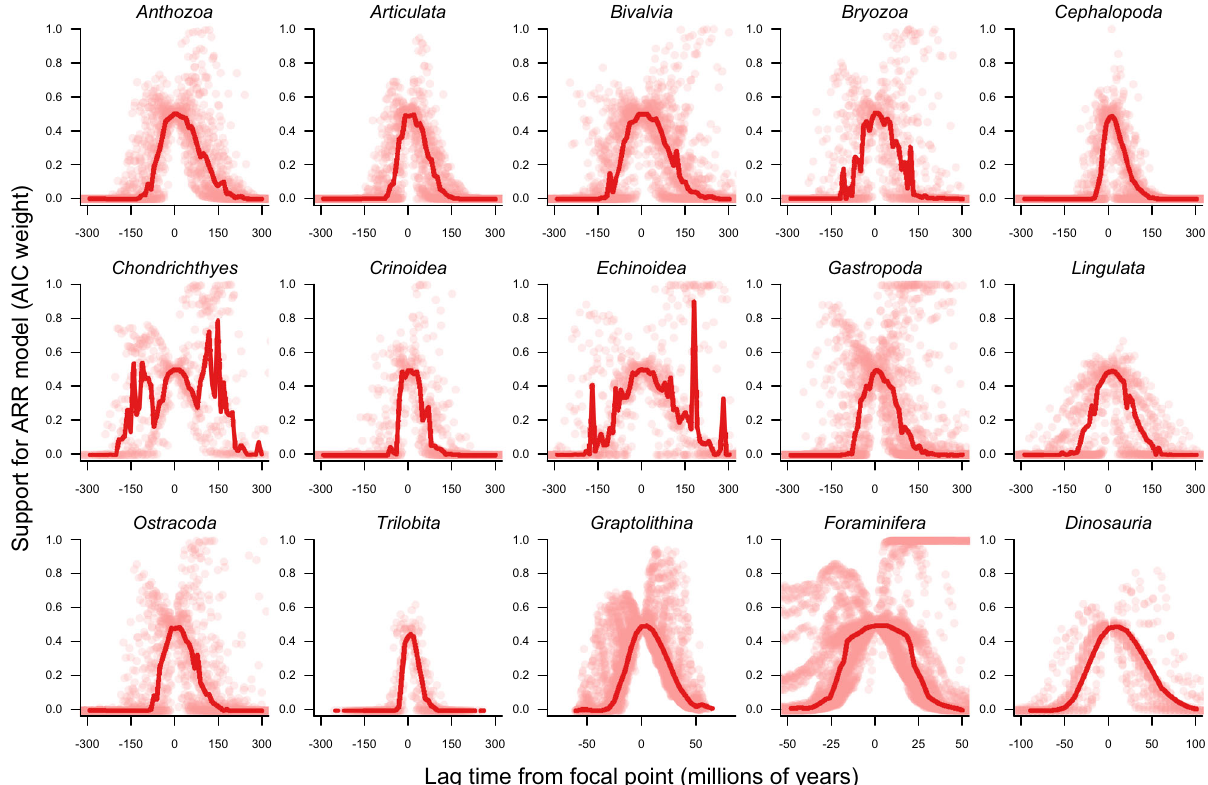
Fig. 4 Probability (AIC weight) of ARR model relative to a nonbiological “ constant ” model as a function of temporal lag. Weights are shown for all pairwise combinations of timepoints for each dataset; red line denotes median weight of ARR model for binned lag times. A value of 0.5 indicates that ARR and constant models have equivalent probability; values approaching 1 imply superior performance of the ARR model. For both positive lags (forwards-in- time) and negative lags (backwards-in-time), the ARR model is outperformed by the constant model. Across all pairs of timepoints ( n = 25740), the ARR model was strongly favored (weight > 0.95) for only 1.8% of comparisons. In contrast, the constant model was strongly favored in 45.5% of comparisons. Beyond a certain point in both directions, the ARR model has minimal explanatory power for any dataset. The number of parameters in ARR and constant models is identical ( n = 1), and identical weight implies identical probability. Corresponding analyses for other models are shown in Supplementary Figs. 9 –